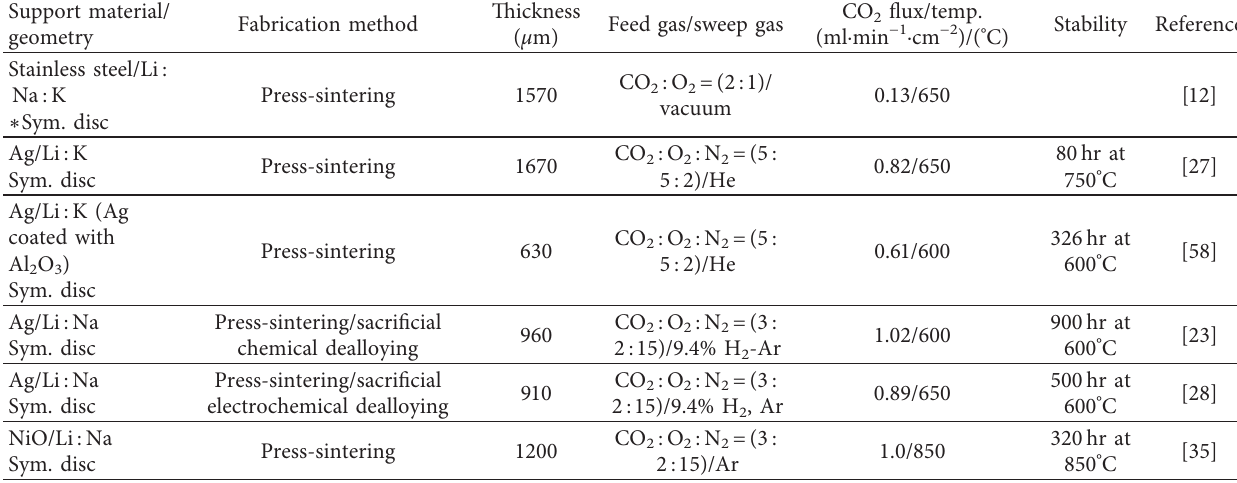
Table 2: Comparison of CO 2 fluxes and stabilities for different types of MECC membranes.